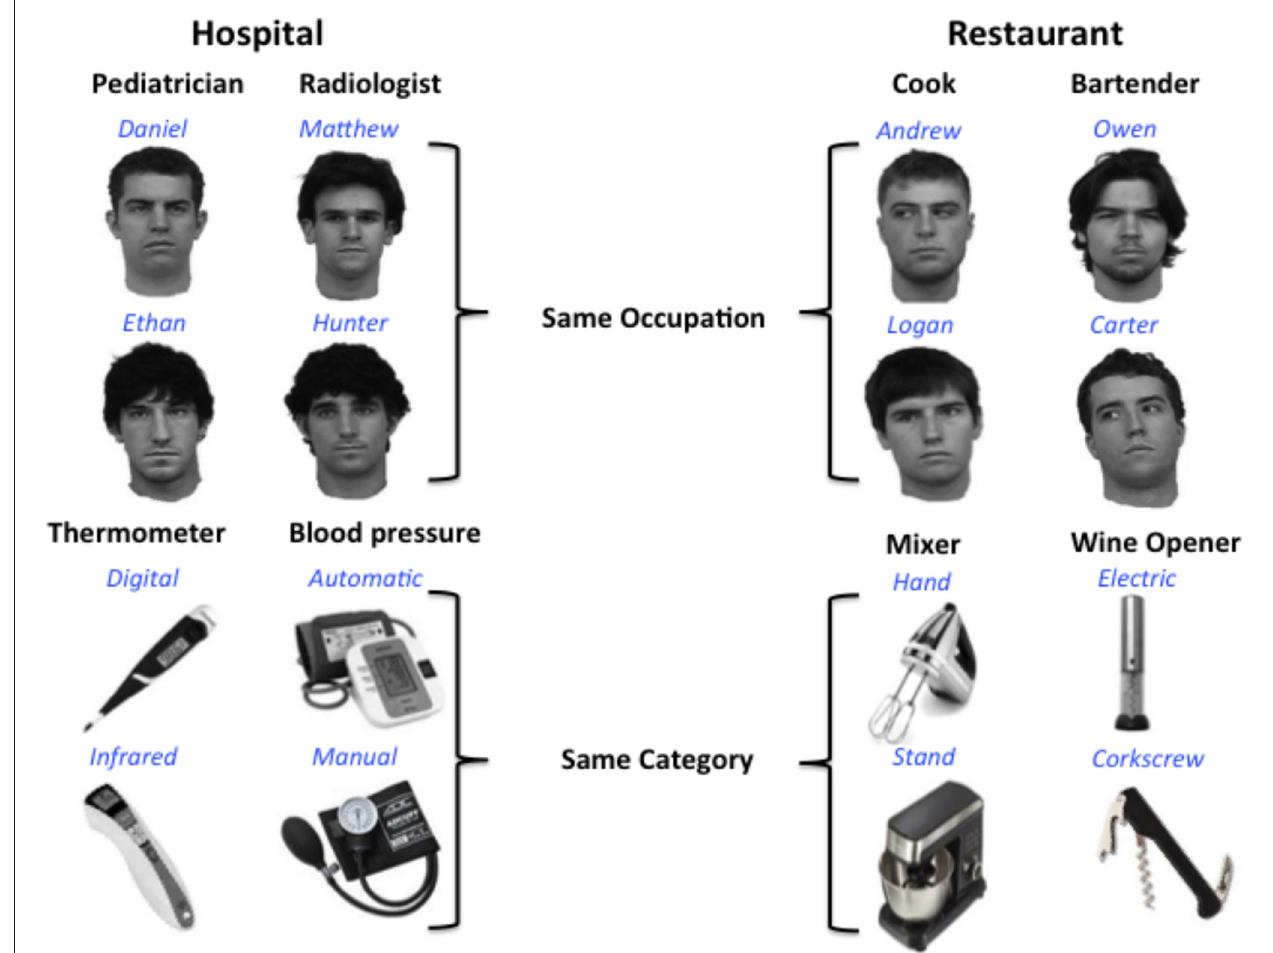
FIGURE 1 | Design for multivoxel pattern analysis (MVPA) analysis. Participants learned to associate distinct faces and objects with identifying names (blue) and category labels or occupations (black). Each occupation or object category is typically found in one of two locations: a hospital or restaurant. Participants were not explicitly informed of the location